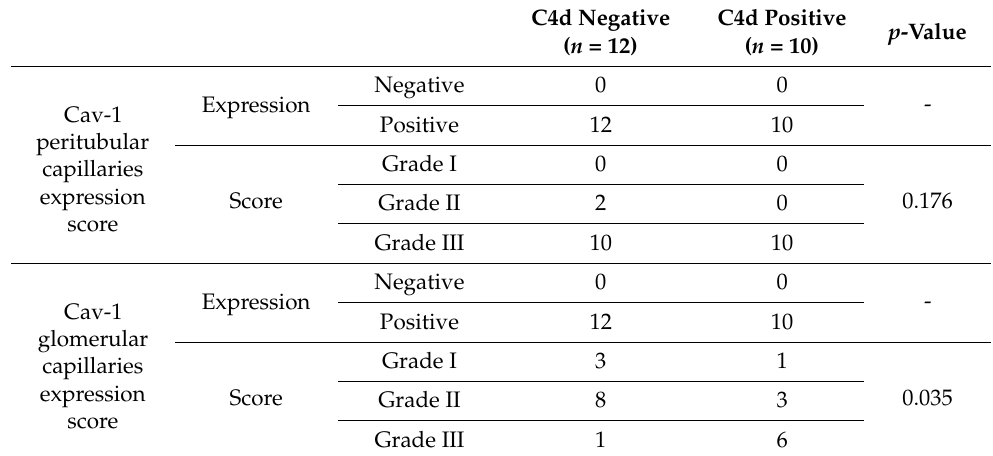
Table 5. Cav-1 IHC score results in c-ABMR samples according to C4d